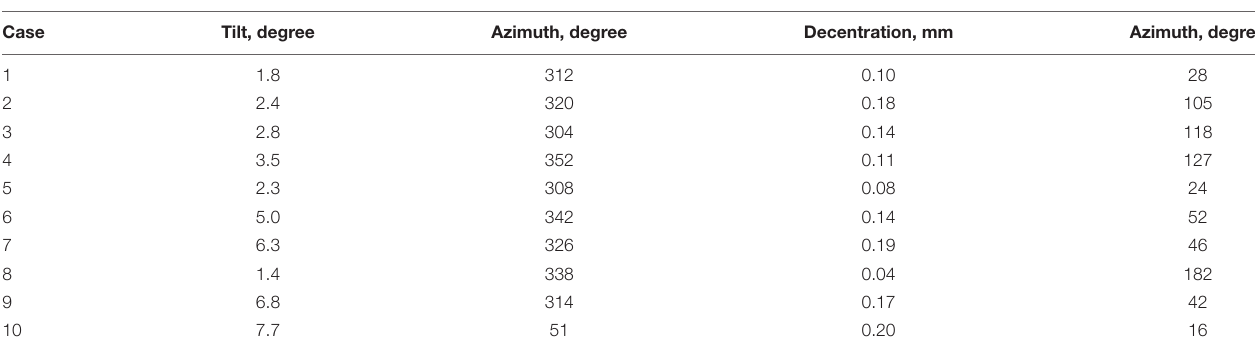
TABLE 3 | Parameters of intraocular lens position at the last follow-up